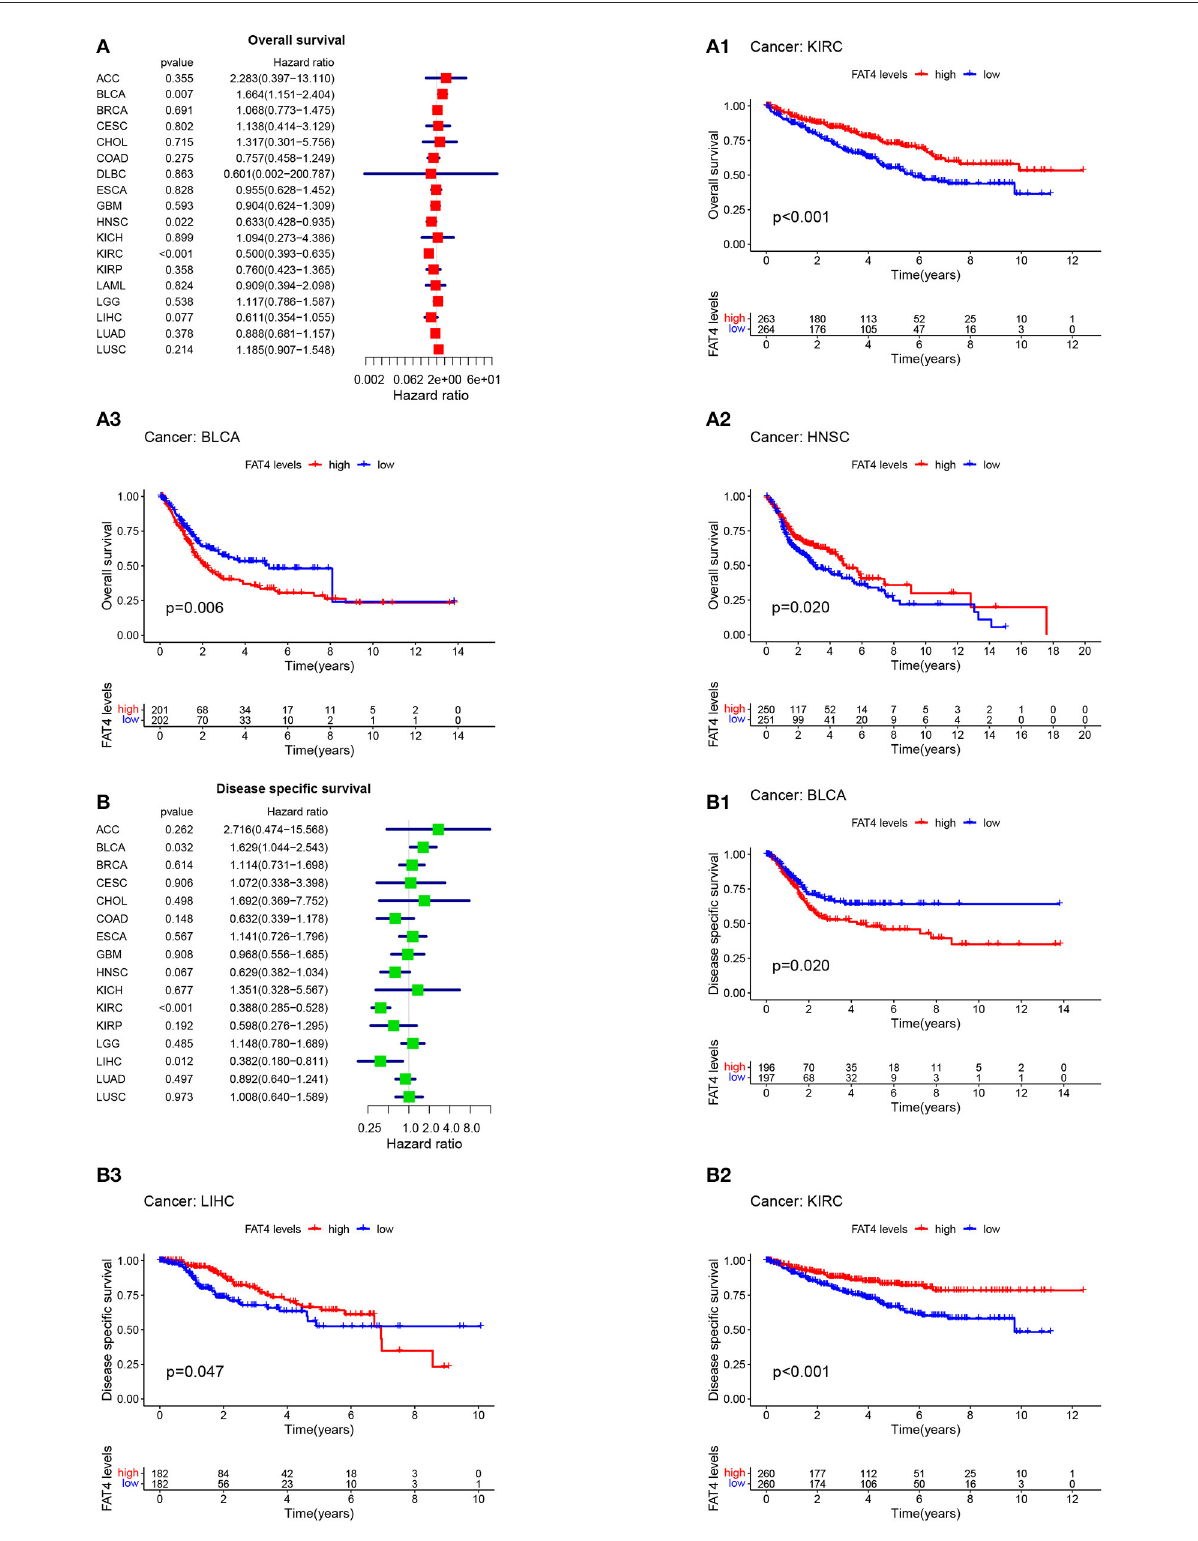
FIGURE3 Correlation between FAT4 expression and survival prognosis of cancers. (A,B) Forest plots of OS and DSS. (A1–B3) Kaplan-Meier curves for OS and